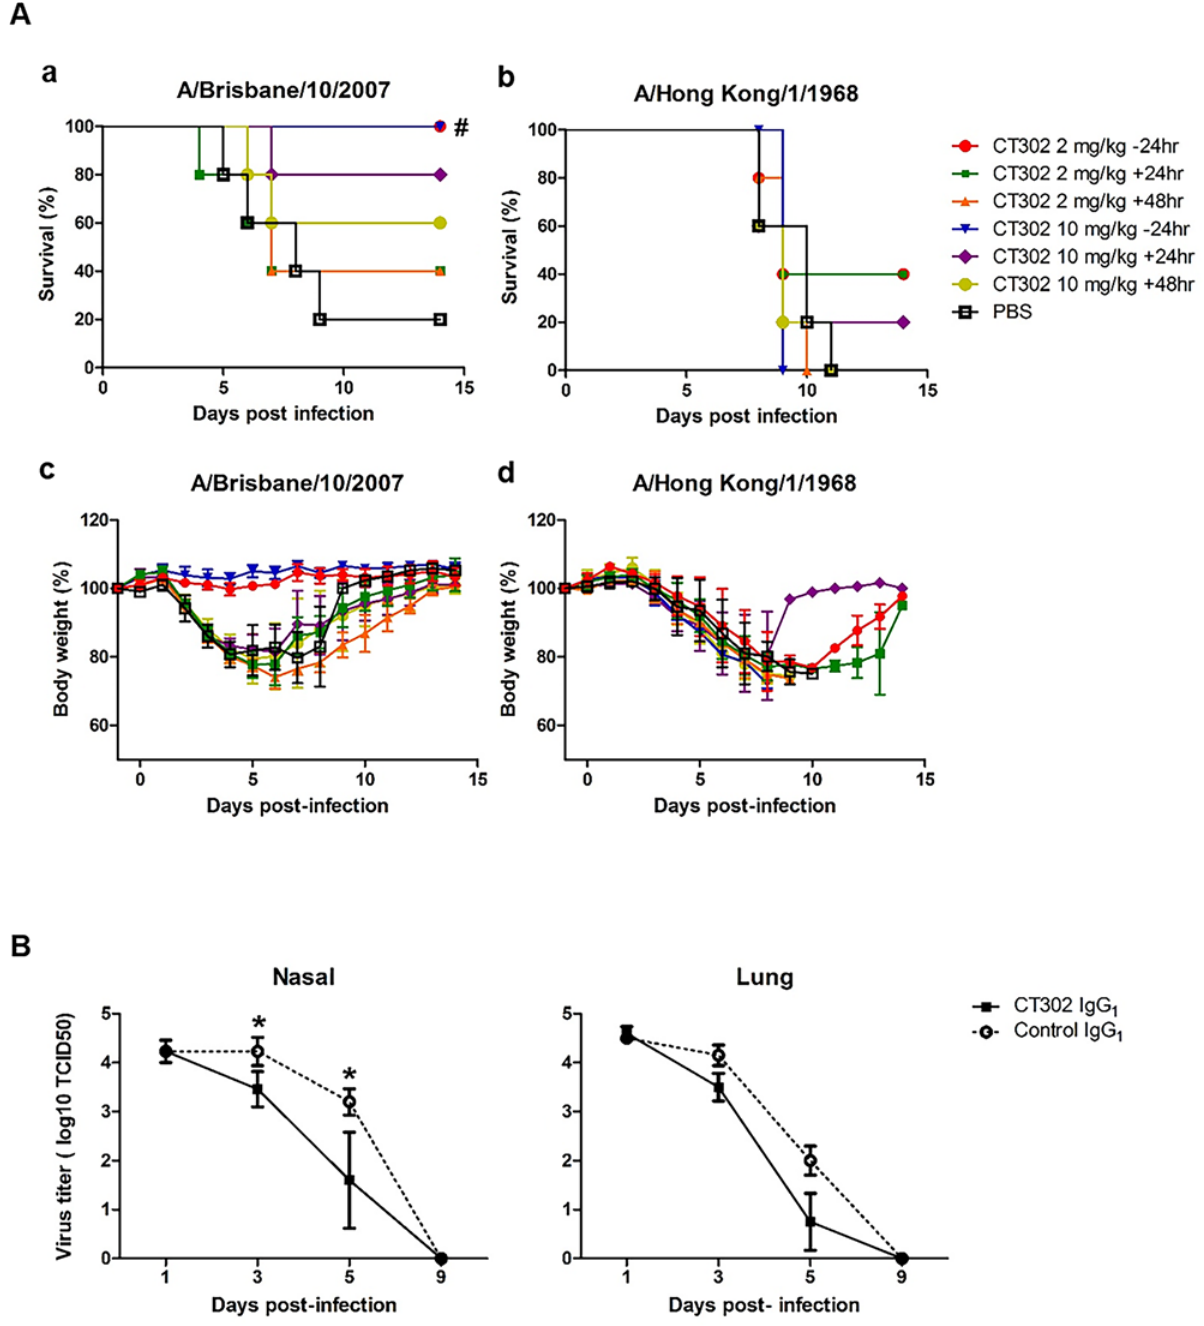
Fig 4. Protective and therapeutic effects of CT302 IgG 1 in influenza virus-infected mice and ferrets. (A) CT302 IgG 1 was administered intraperitoneally to mice at -24, +24, or +48 hr from infection with A/NYMC X-171 strain (mouse-adapted A/Brisbane/10/2007 strain) (a, c) or A/Hong kong/1/1968 (b, d), and survival rate (a, b) and body weight change (c, d) were monitored twice daily up to 14 days. (B) Ferrets were challenged with the influenza virus and treated intravenously either with 30 mg/kg CT302 IgG 1 or control IgG 1 after 1 day. Subsequently, viral titers in the nasal fluid and lung tissue were determined. # p < 0.05 (vs. PBS) determined by log-rank (Mantel-Cox) test. * p < 0.05 (vs. control) on day 5, determined by Student ’ s t-test. TCID dose required to cause cytopathic effects on 50% of inoculated cells.